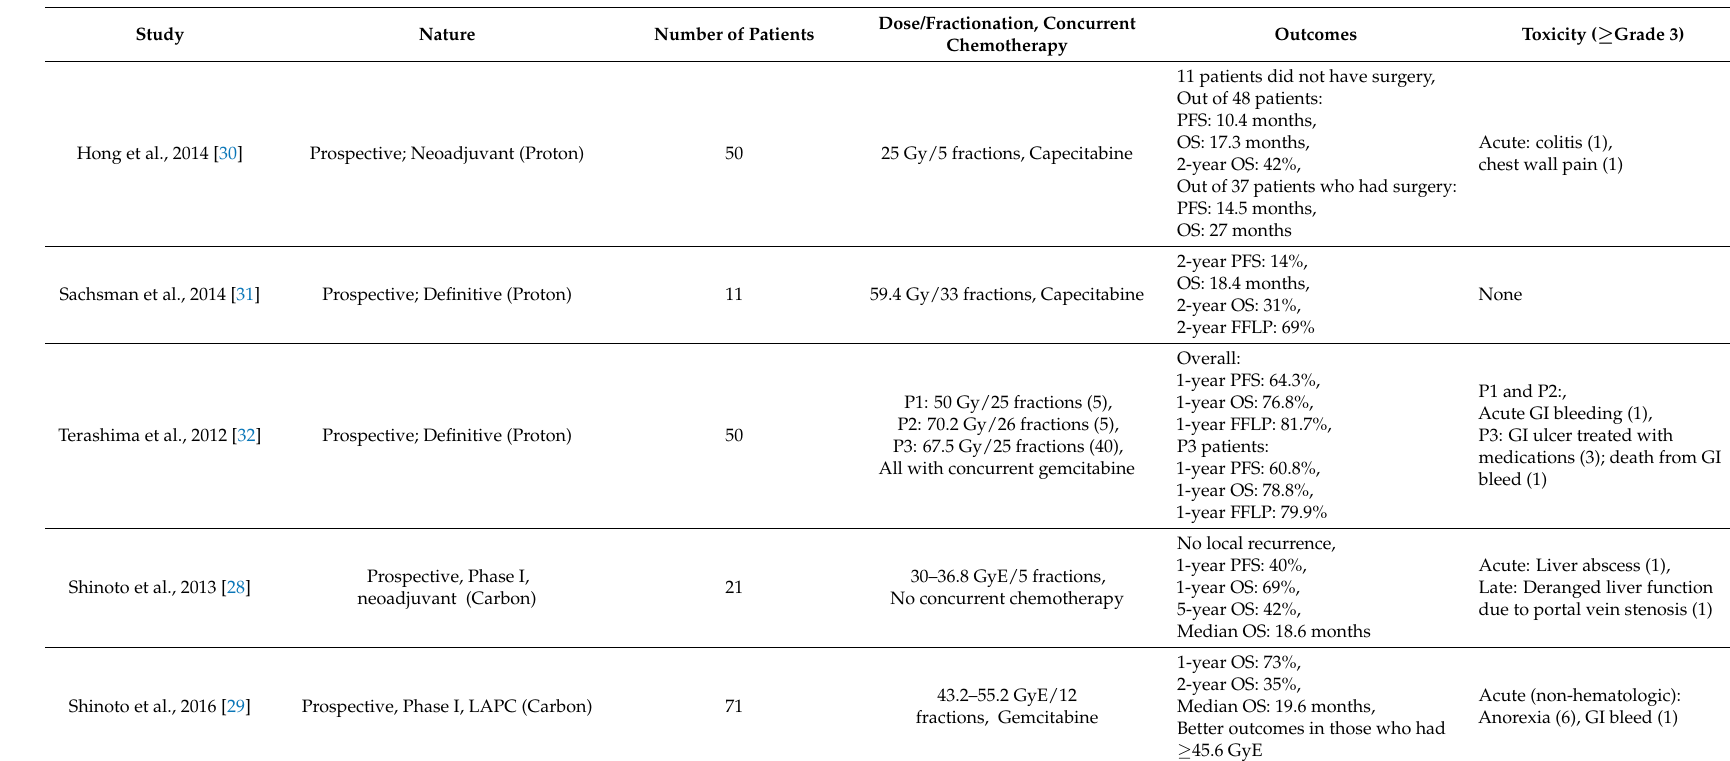
Table 3. Summary of particle therapy